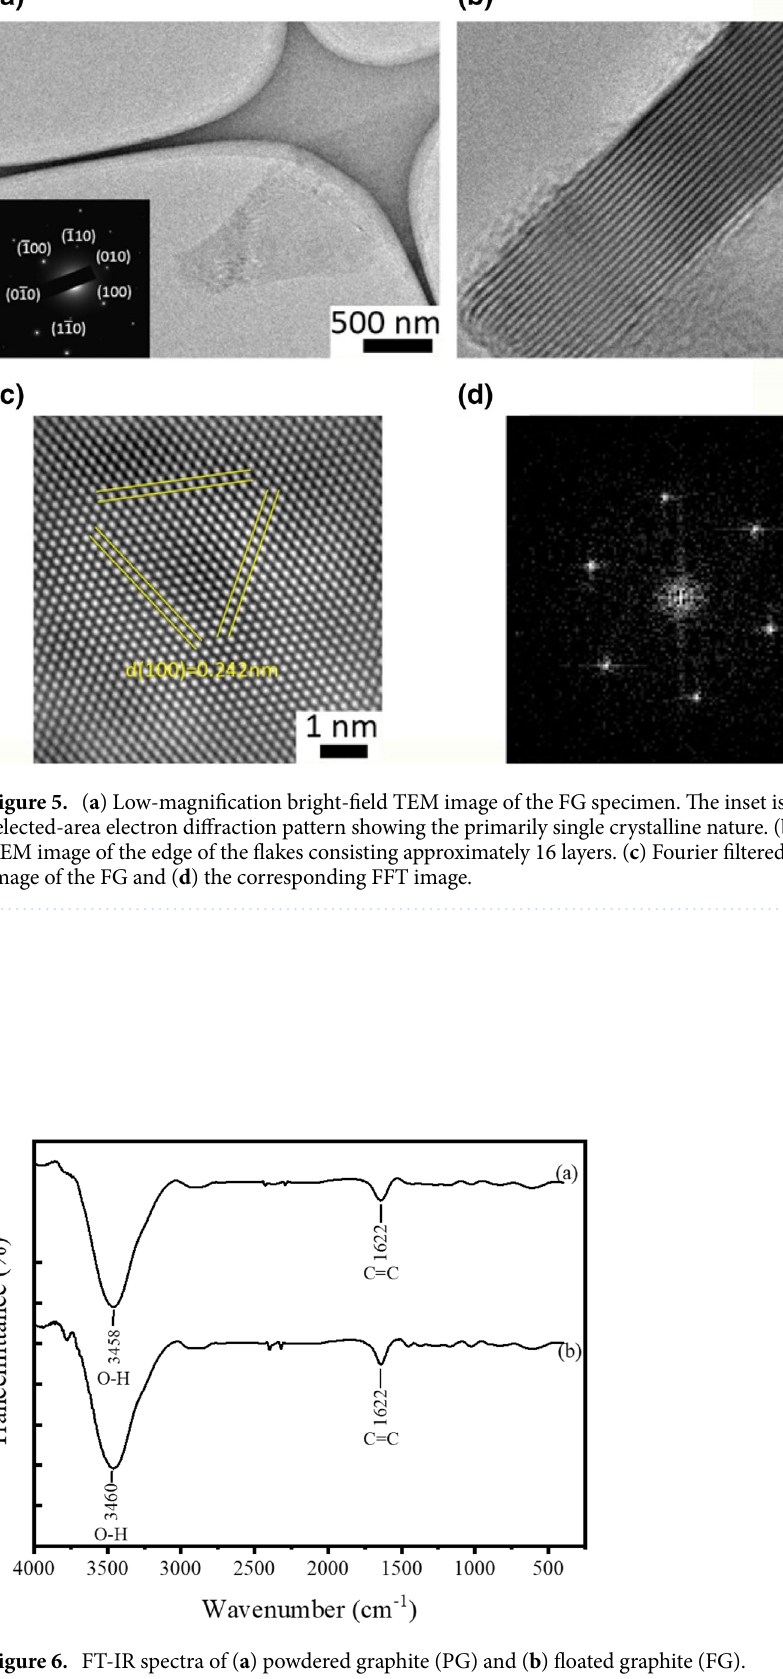
Figure 6. FT-IR spectra of ( a ) powdered graphite (PG) and ( b ) floated graphite